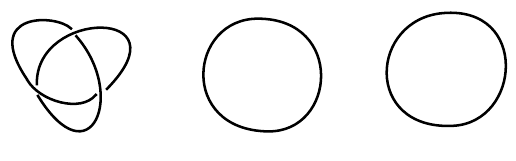
Figure 4 . Three unlinked